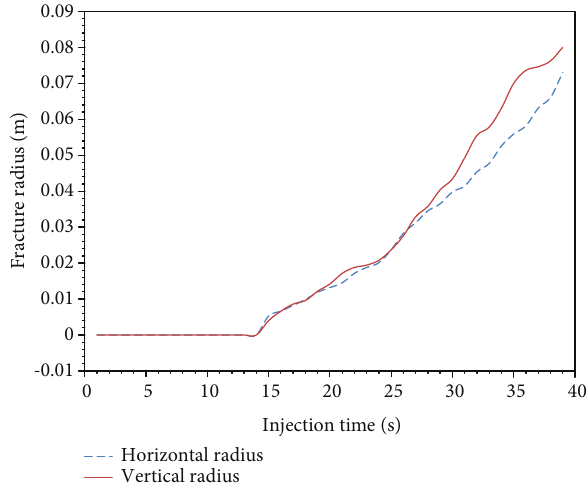
Figure 16: Development of horizontal and vertical fracture radii versus injection time in the orthogonal jointed sample.